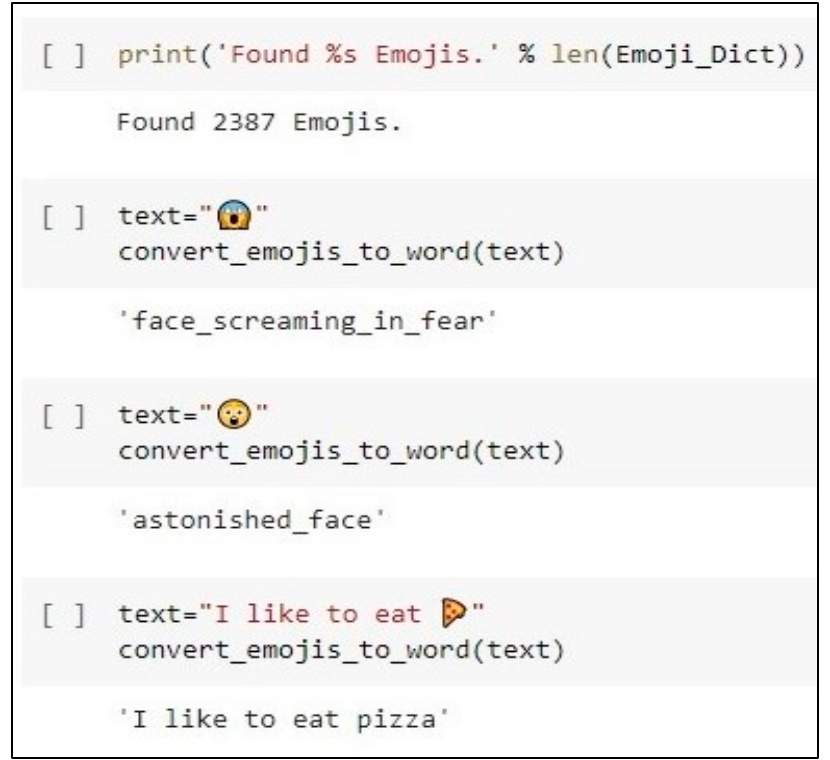
Figure 10. The screenshot of code of replacing emojis with words.